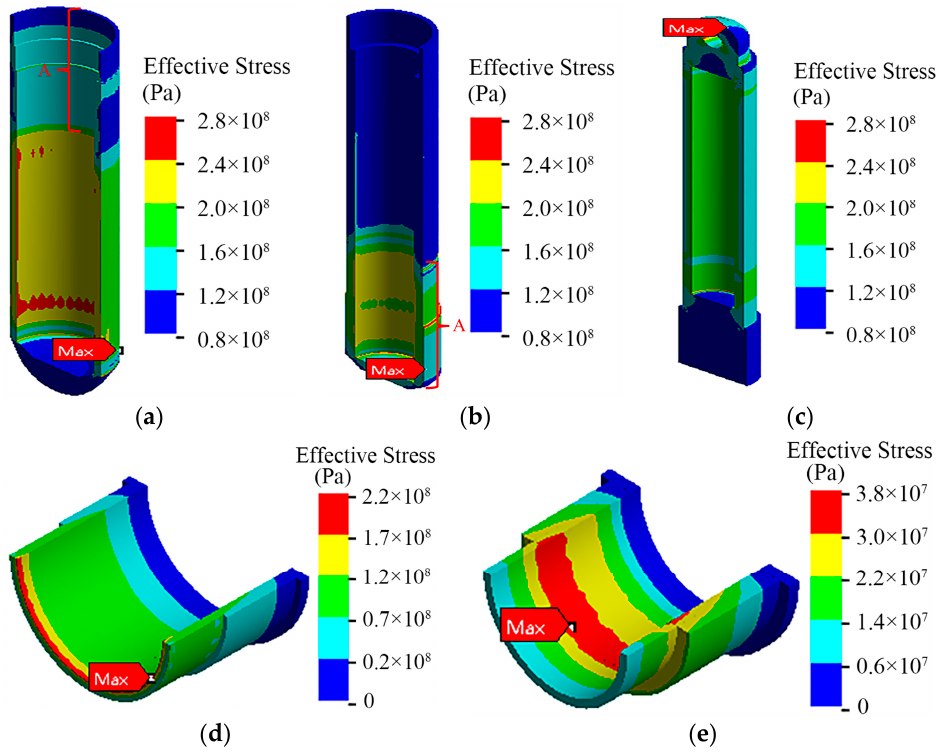
Figure 12. ( a ) Stress distribution of the one-level cylinder under condition ( b ). ( b ) Stress distribution of the two-level cylinder under condition ( b ). ( c ) Stress distribution of the movable column under condition ( b ). ( d ) Stress distribution of the hinged hole of the one-level guide sleeve under condition ( b ). ( e ) Stress distribution of the two-level guide sleeve under condition ( b ).